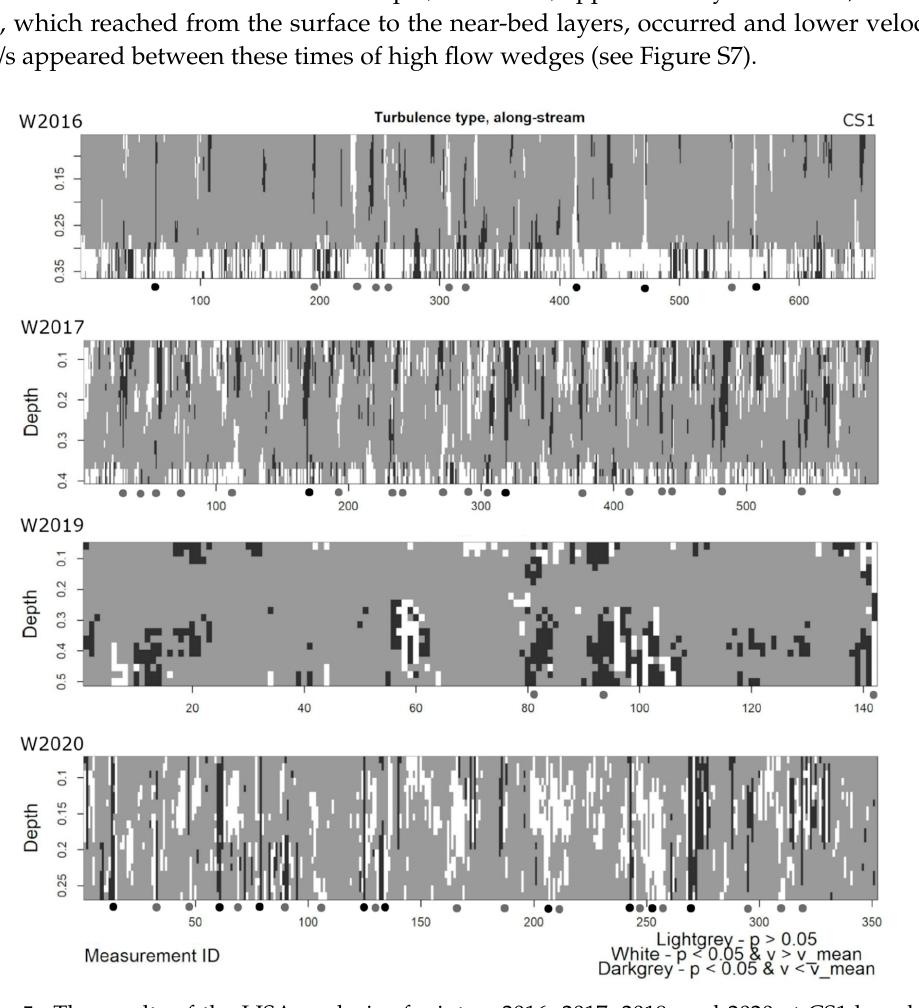
Figure 5. The results of the LISA analysis of winters 2016, 2017, 2019, and 2020 at CS1 based on streamwise velocity. The W2018 results can be seen from Figure 3. Measurement ID means the sample numbers ( n ), and therefore also represents seconds. W2019 and W2020 measurements were shorter in time. The black dots indicate the occurrence times of statistically significant strong high and low flow wedges reaching from the surface to the riverbed. The grey dots indicate the times when there is weaker wedge (i.e., a cluster has broken with a few cells within the vertical water column).